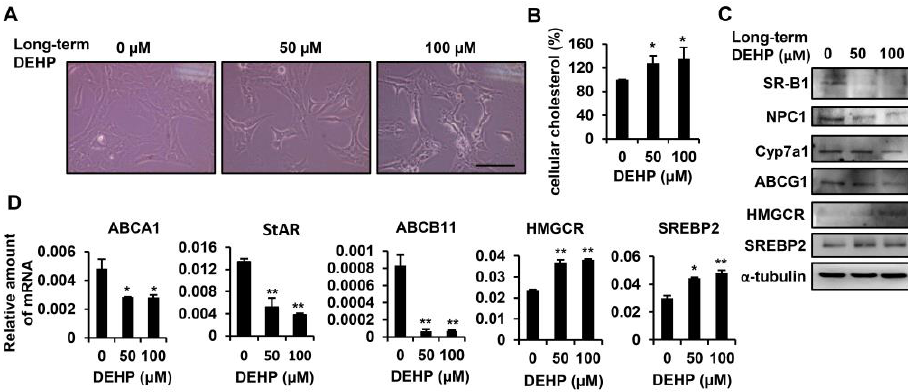
Figure 3. E ff ects of long-term exposure to low-dose DEHP on cholesterol metabolism in HSC-T6 cells. ( A ) Morphological changes induced by long-term, low-dose DEHP exposure. Scale bar indicates 20 µ m. ( B ) Intracellular cholesterol content in long-term, low-dose, DEHP exposed HSC-T6 cells. ( C ) Western blot analysis of SR-B1, NPC1, Cyp7a1, ABCG1, HMGCR, SREBP2, and α -tubulin in long-term, low-dose, DEHP exposed HSC-T6 cells. ( D ) Quantitative real-time polymerase chain reaction (Q-PCR) analysis of ABCA1, StAR, ABCB11, HMGCR, and SREBP2 in long-term, low-dose, DEHP exposed HSC-T6 cells. * p < 0.05; ** p < 0.01 vs. 0 µM.